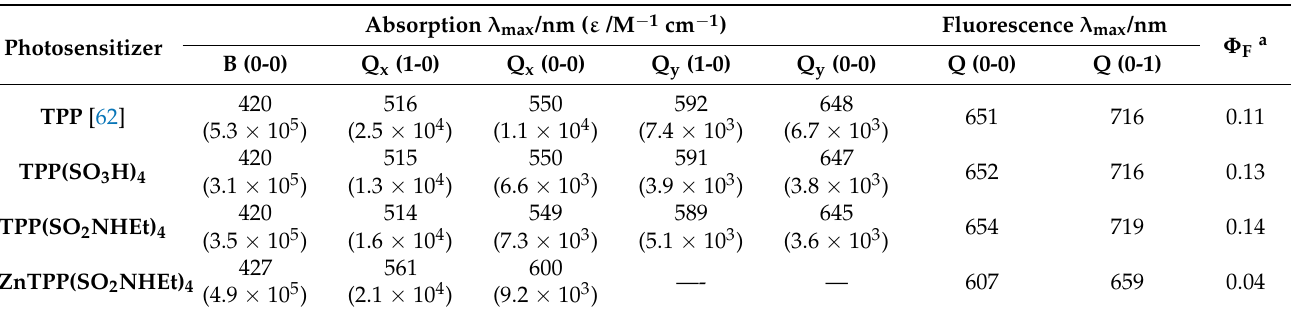
Table 1. Maximum of absorption and molar absorption coefficients of TPP(SO 3 H) 4 , TPP(SO 2 NHEt) 4 , and ZnTPP(SO 2 NHEt) 4 and TPP used as reference and maximum of fluorescence emission and fluorescence quantum yield in DMF.